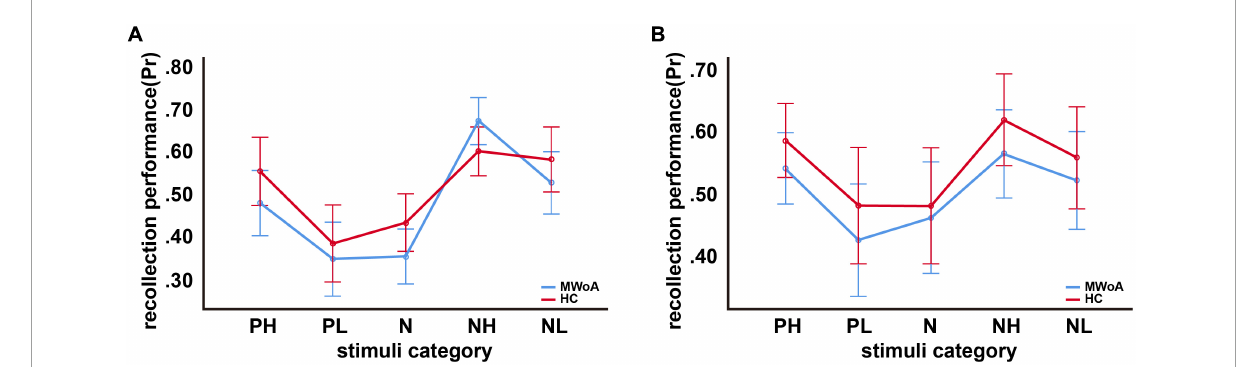
FIGURE2 Recollection performance as a function of picture type. (A) Incidental encoding, (B) intentional encoding. Note that Pr represents recollection performance, which varies from 0 (no discrimination between old and new pictures) to 1 (perfect discrimination). Bars represent estimated marginal means ± standard deviations.